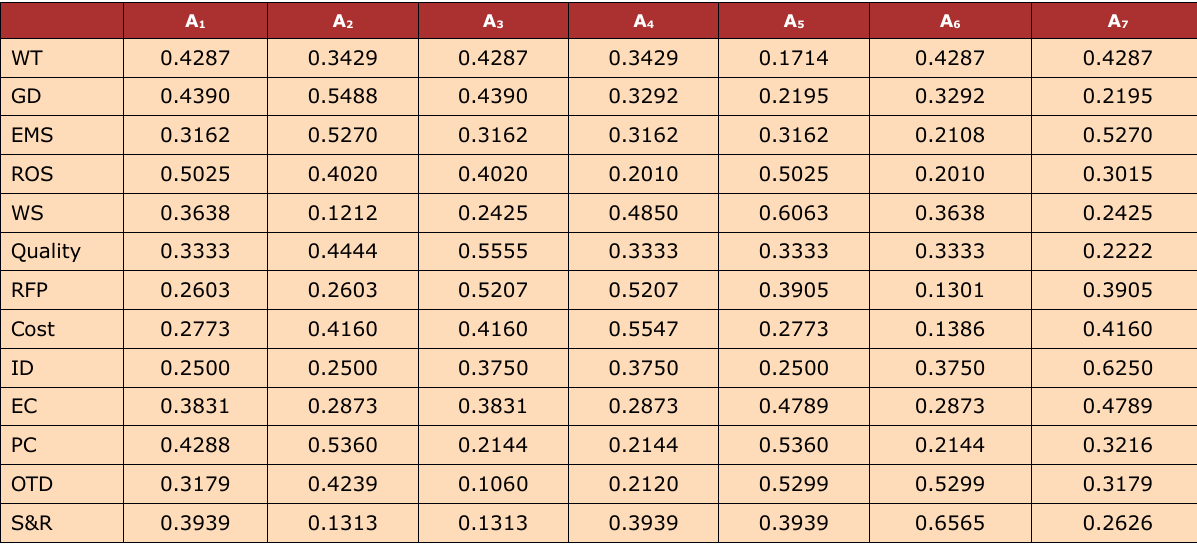
Table 12. Normalized decision matrix